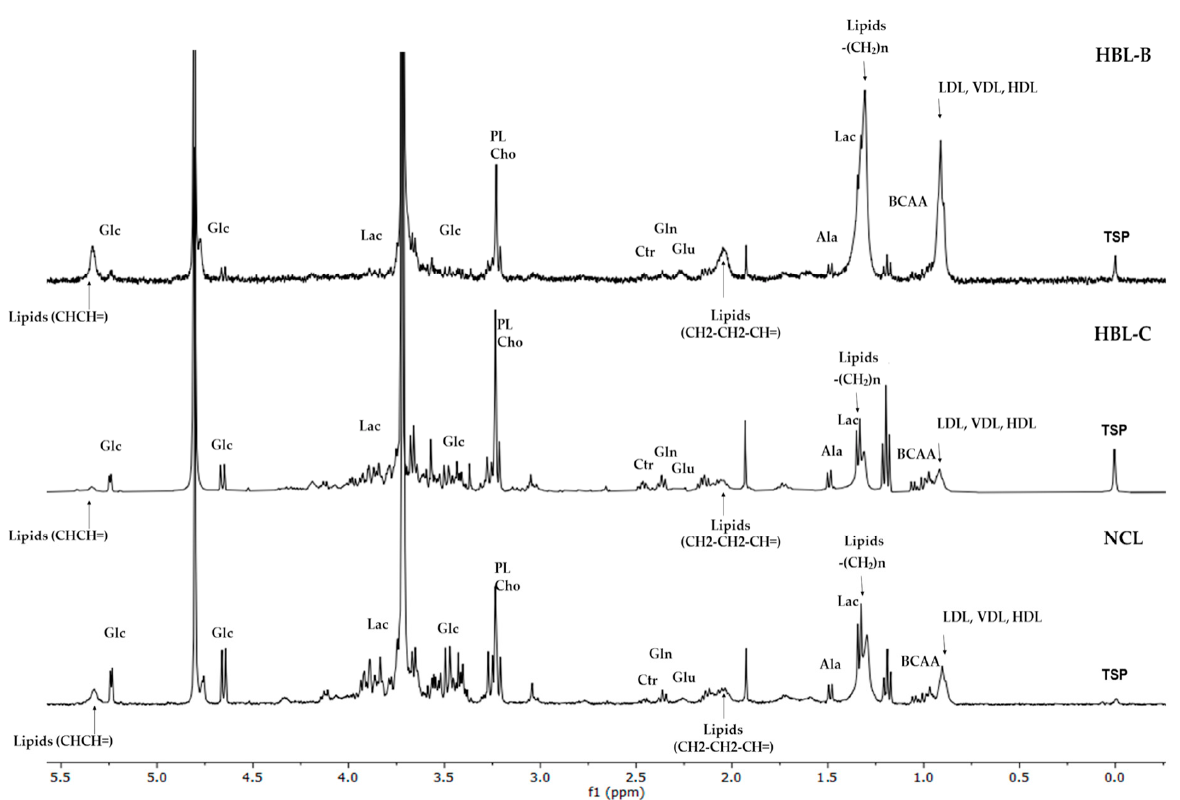
Figure 1. HR-MAS 1 H-NMR spectra of liver tissue samples, from the bottom to the top: non-cancer liver (NCL) sample, hepatoblastoma sample (HBL-C) taken from the center of the tumor, and hepatoblastoma sample taken from the border of the tumor (HBL-B) in 0.0-5.5 ppm. Identification of the tissue metabolites is given in Table 1.